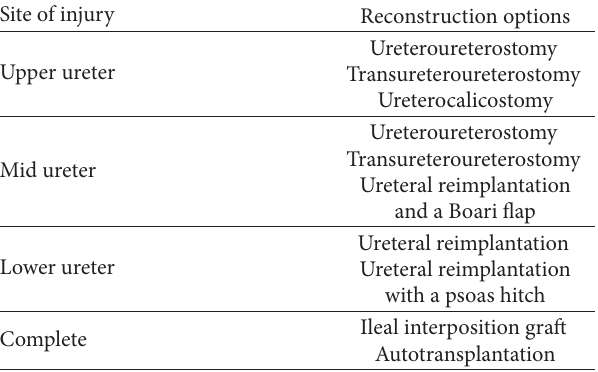
Table 2: Reconstruction options by site of injury